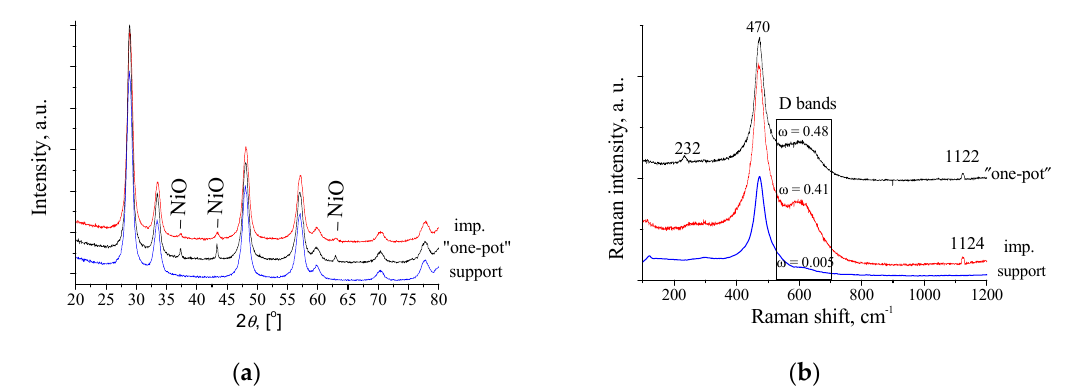
Figure 2 . XRD patterns ( a ) and Raman spectra ( b ) of Ni/Ce 0.75 Zr 0.25 O 2 −δ catalysts prepared via the Pechini method and calcined at 700 °C.